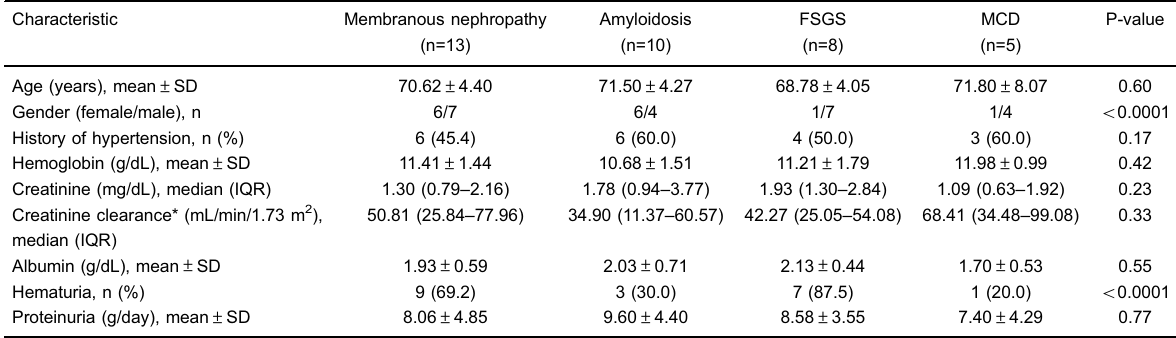
FSGS: focal segmental glomerulosclerosis; MCD: minimal change disease; IQR: interquartile range. *Calculated with the Chronic Kidney Disease Epidemiology equation. One-way analysis of variance or Kruskal-Wallis test.